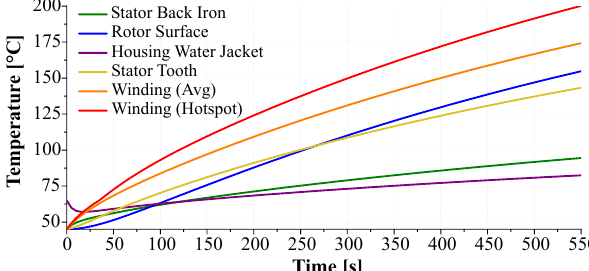
Figure 15. Transient thermal characteristics at the peak torque operation, 3400 Nm at 950 RPM.